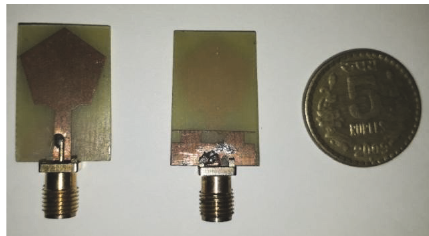
Figure 2: Fabricated prototype of the antenna with front and bottom